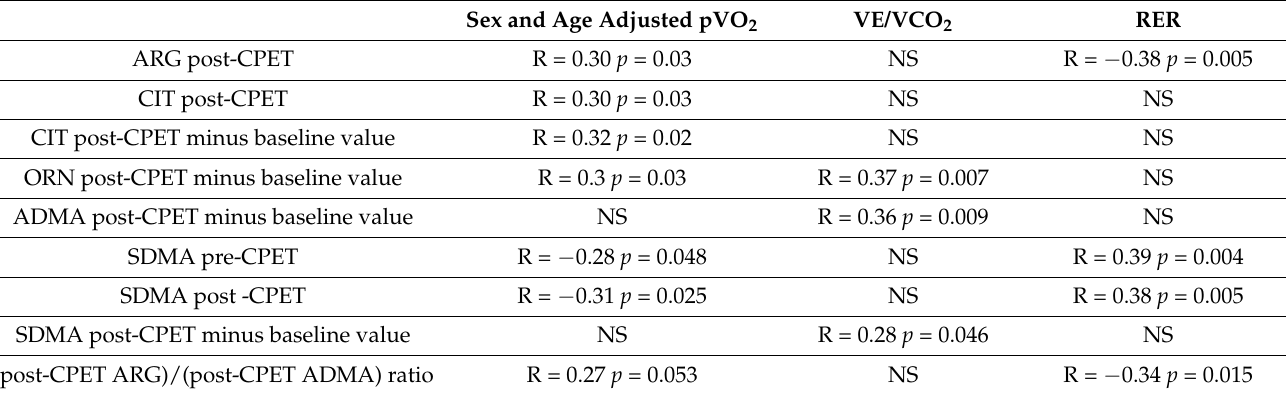
Table 3. Correlation between the concentration of arginine derivatives and parameters of exercise capacity measured by cardiopulmonary exercise test. Data are presented as correlation coefficient and p value; only statistically significant correlations are presented. ADMA = asymmetric dimethylargi- nine, ARG = arginine, CIT = citrulline, CPET = cardiopulmonary exercise test, NS = not statistically significant, ORN = ornithine, pVO2 = peak O 2 consumption, R = correlation coefficient, RER = the expiratory exchange ratio, SDMA = symmetric dimethylarginine, VE/VCO 2 slope = the relation between minute ventilation and carbon dioxide production. Sex and Age Adjusted pVO